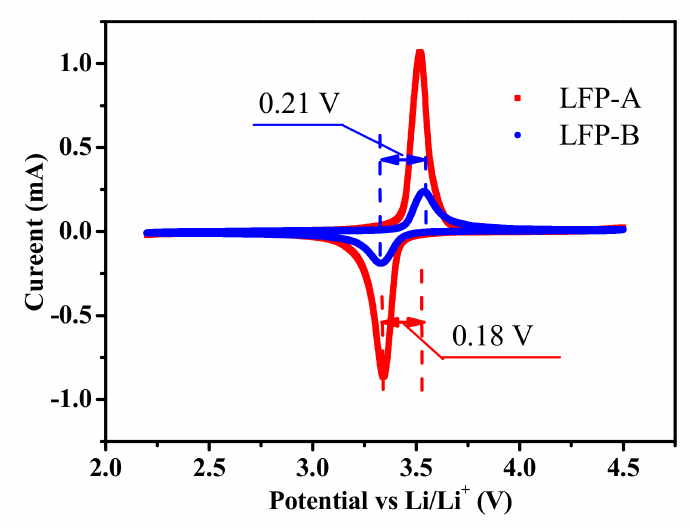
Figure 8. Cyclic voltammograms of the two composites at a scan rate of 0.1 mV s − 1